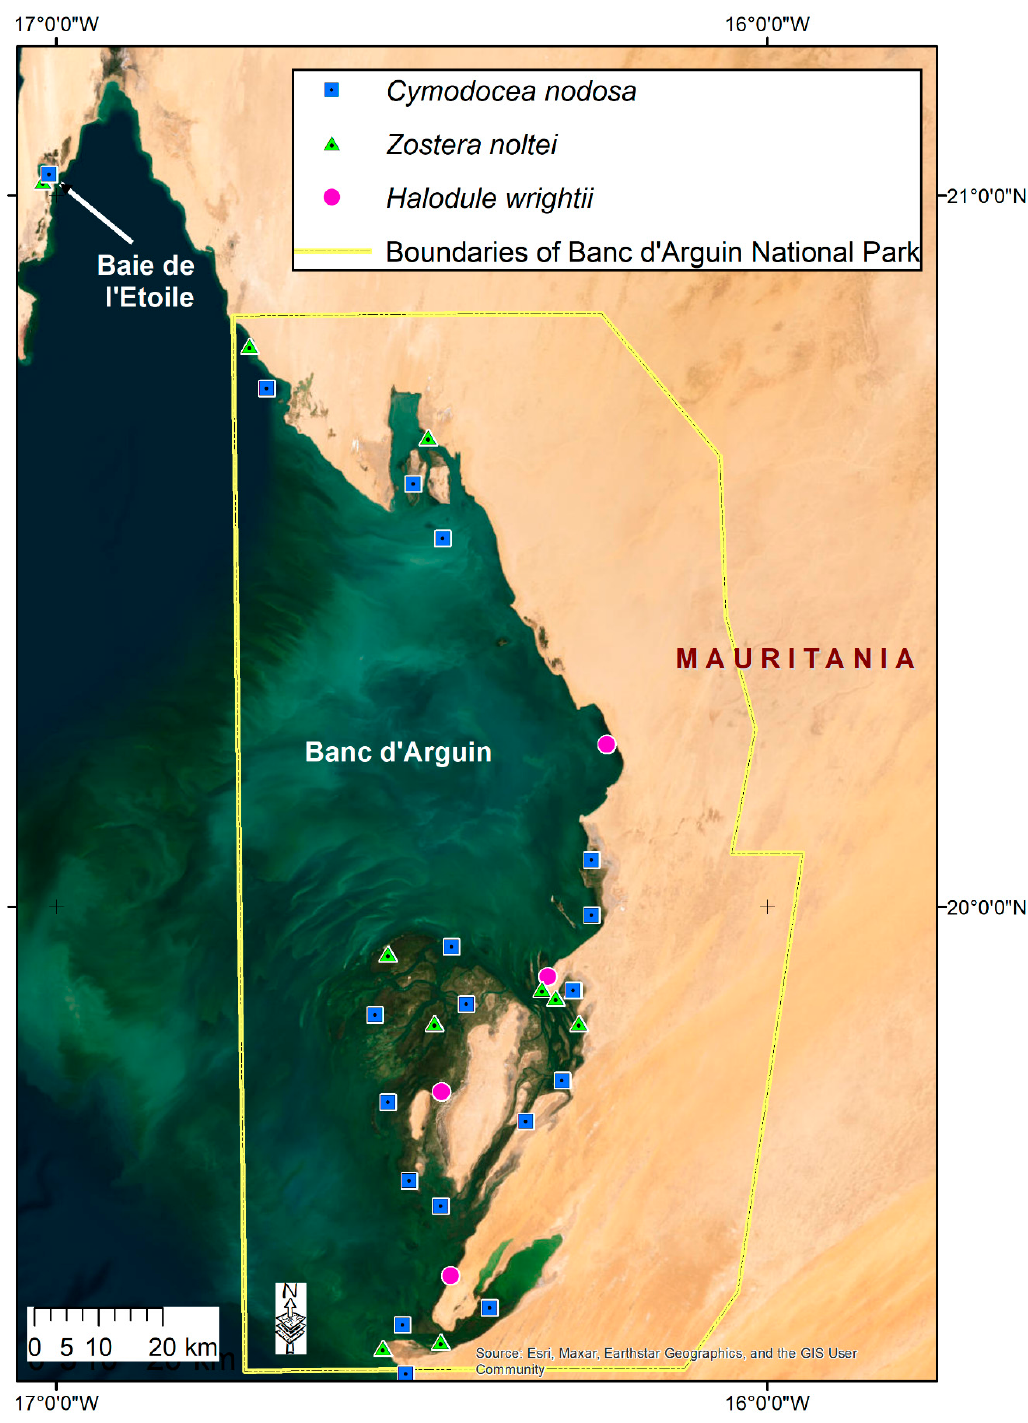
Figure 3. Seagrass distribution in Mauritania.